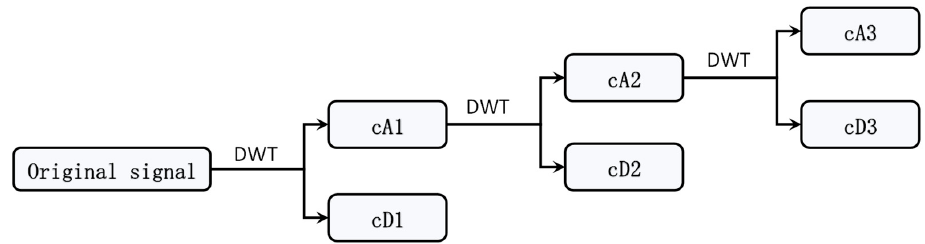
Figure 2. Structure of wavelet decomposition.